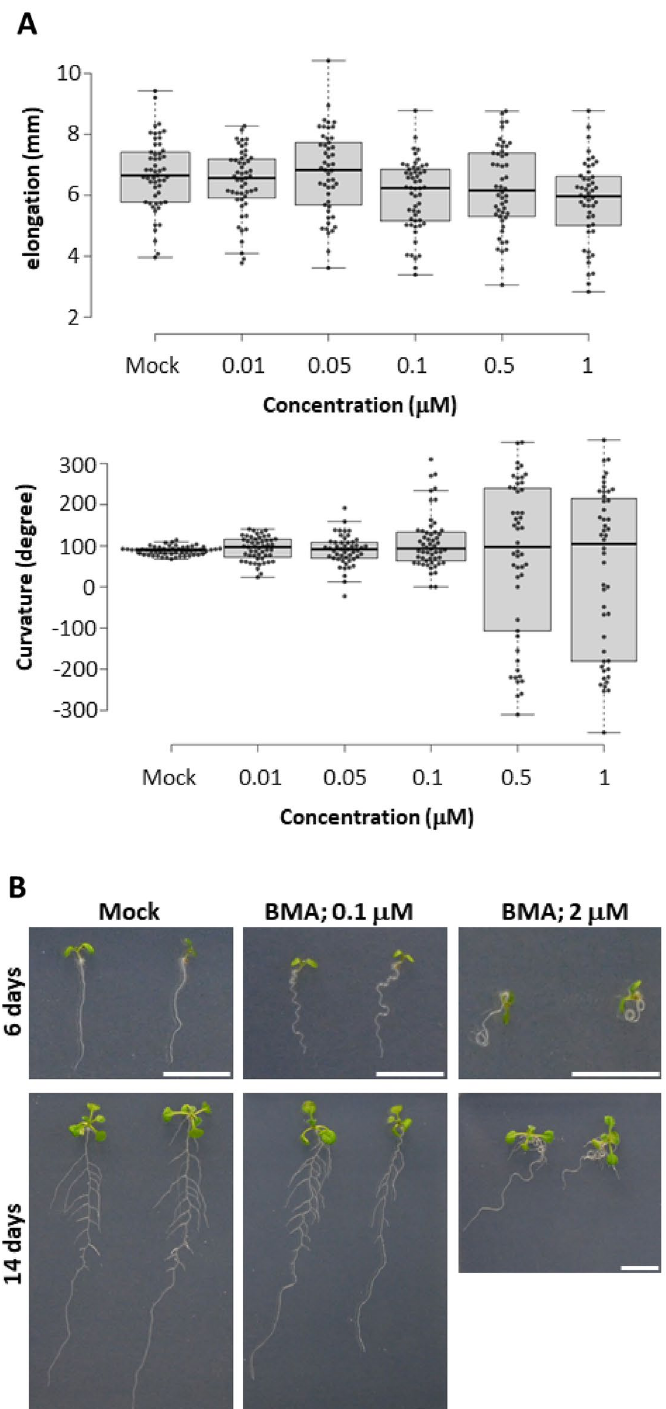
Figure 4. ( A ) Inhibitory activity tests of gravitropic bending and elongation for dose–response relationship study of BMA using Arabidopsis seedlings. Center lines show the medians; box limits indicate the 25th and 75th percentiles as determined by R software; whiskers extend 1.5 times the interquartile range from the 25th and 75th percentiles, outliers are represented by dots; width of the boxes is proportional to the square root of the sample size; data points are plotted as open circles. n = 53, 51, 49, 54, 50, 48 sample points. No significant differences in root elongation were found among all data (Tukey–Kramer, P < 0.01). ( B ) Effect of BMA on the growth of Arabidopsis seedlings. Arabidopsis seedlings were grown on a vertical agar plate containing 0.1 and 2 μM BMA for 6 and 14 days under continuous light conditions. Bar = 1